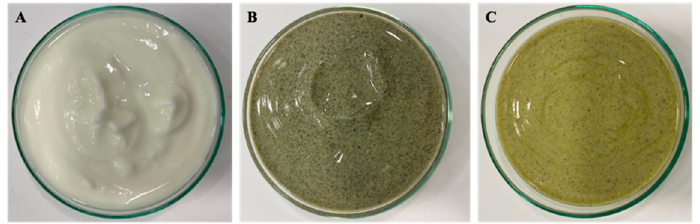
Figure 1. Yogurt products preparation: ( A ) Control Yogurt; ( B ) Yogurt with 2% ( w / w ) of I. galbana freeze-dried biomass; ( C ) Yogurt with 2% ( w / w ) of I. galbana ethyl acetate